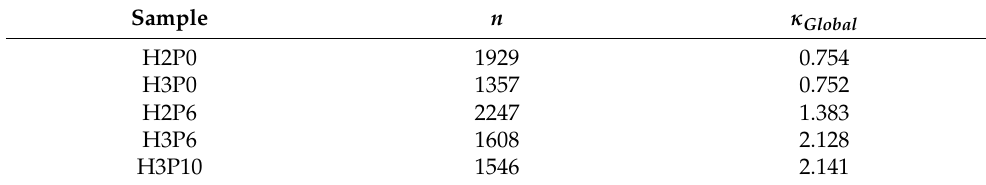
Table 6. Global connectivity and the total number of pores of geopolymer